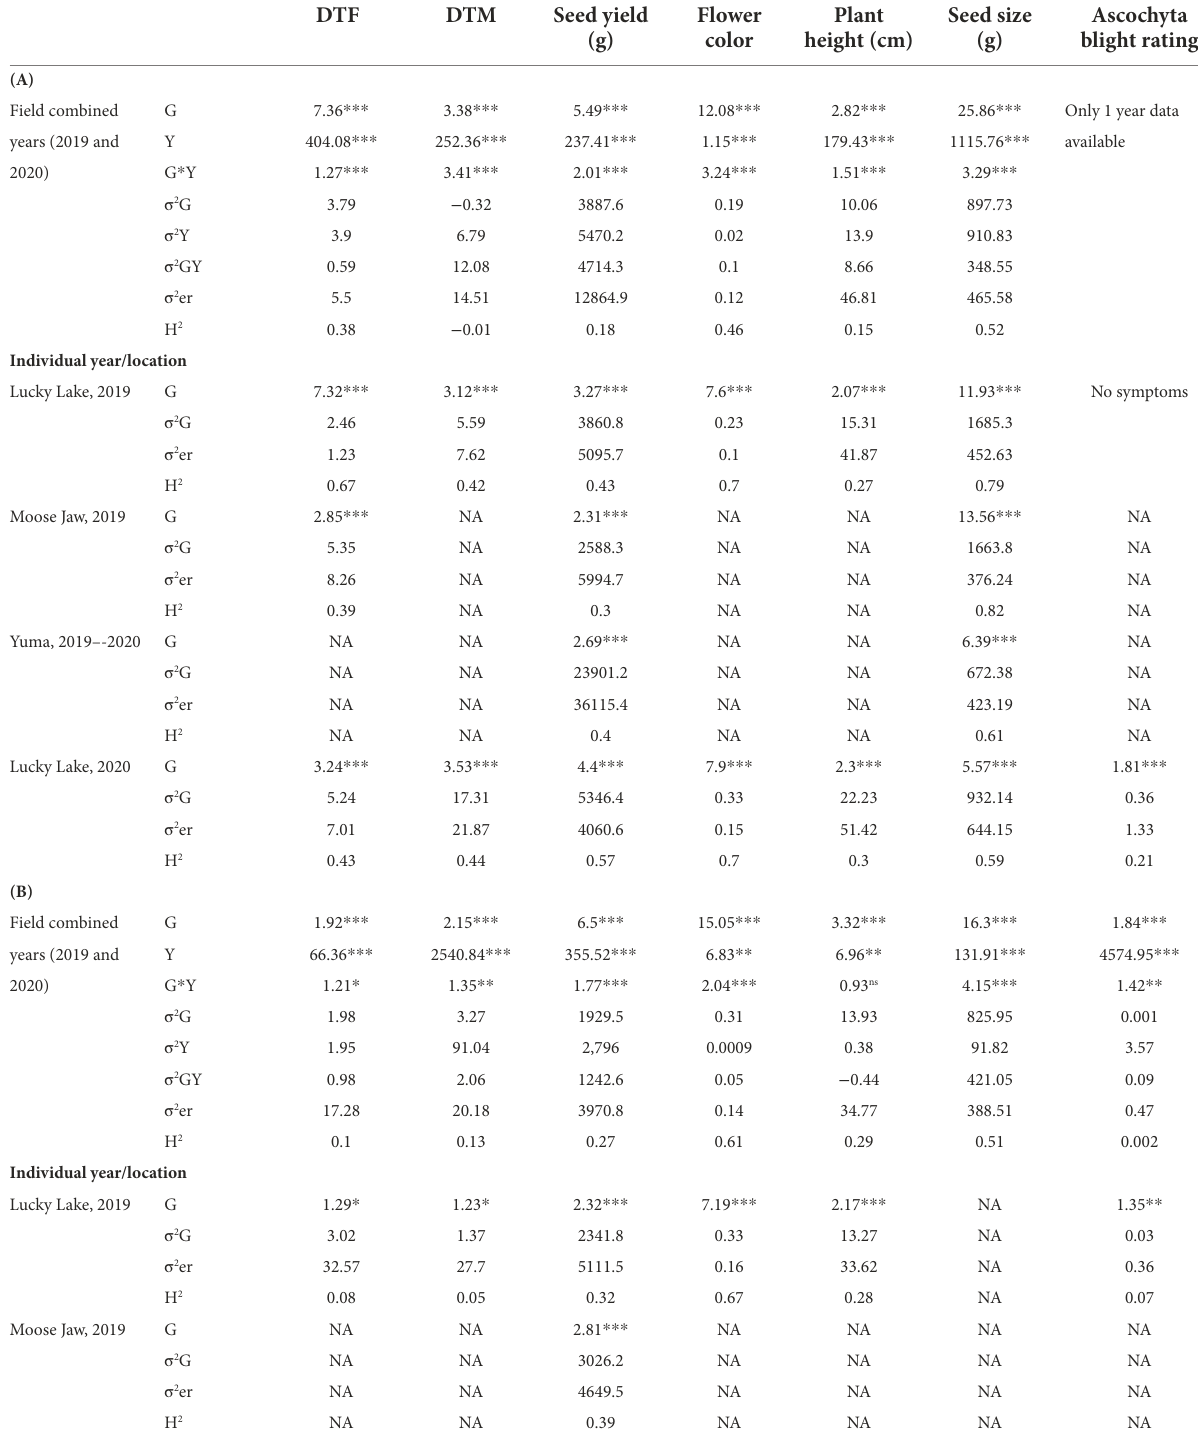
TABLE 1 ANOVA for days to flowering (DTF), days to maturity (DTM), seed yield, flower color, plant height, seed size (1,000 seed weight), and ascochyta blight rating under (A) normal seeding (SD1) and (B) late seeding (SD2) for the interspecific population was evaluated under field conditions at Lucky Lake and Moose Jaw, Saskatchewan in 2019, Yuma, Arizona in 2019–2020, and Lucky Lake, Saskatchewan in